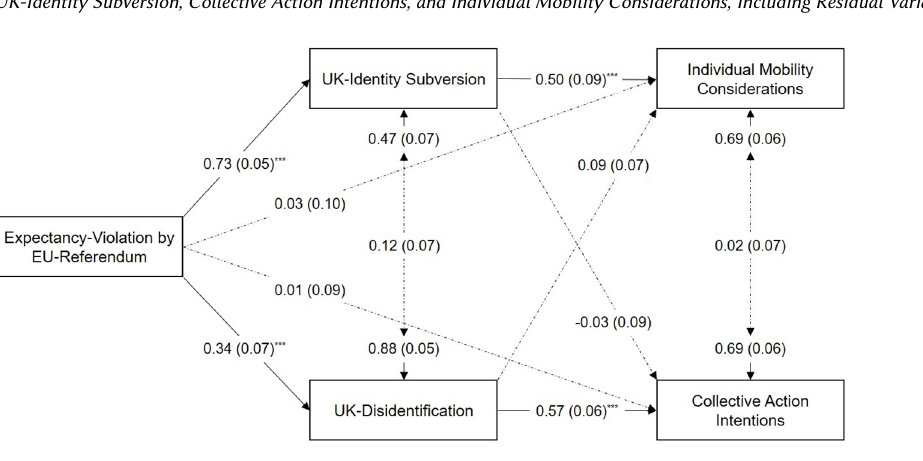
Standardized Relationships (Standard Errors in Parentheses) Between Perceptions of the EU-Referendum as an Expectancy-Violation, UK-Disidentification, UK-Identity Subversion, Collective Action Intentions, and Individual Mobility Considerations, Including Residual Variances